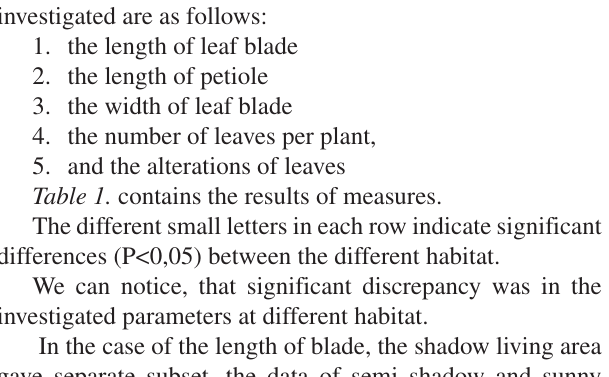
Table 1. contains the results of measures.